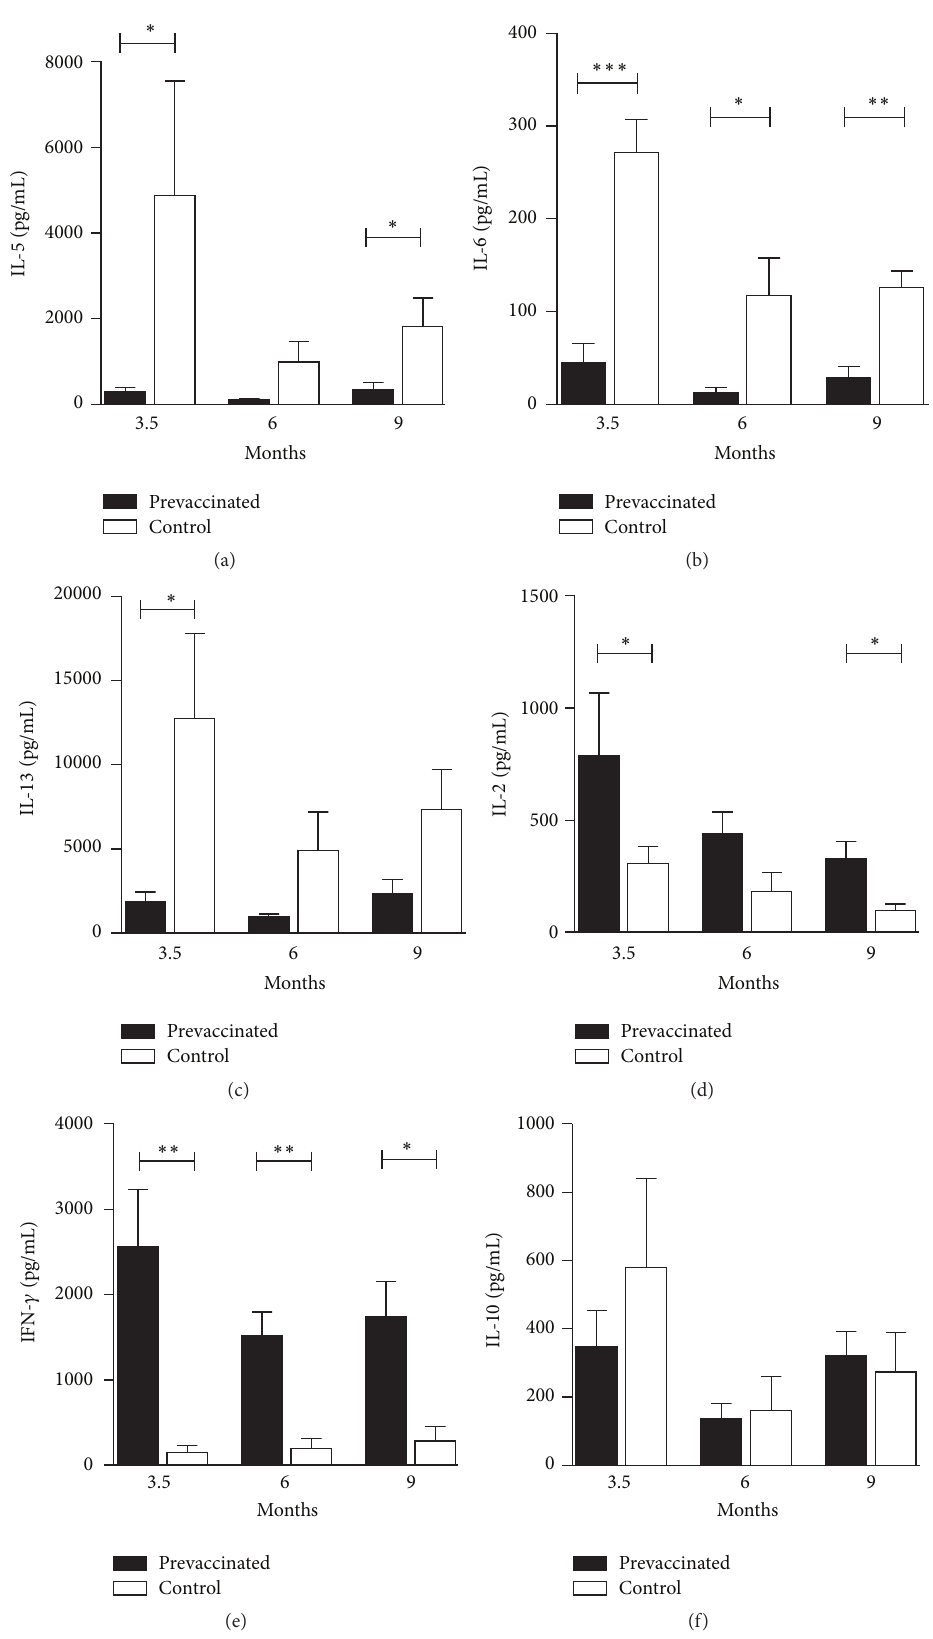
Figure 2: Levels of IL-5 (a), IL-6 (b), IL-13 (c), IL-2 (d), IFN- 𝛾 (e), and IL-10 (f) were determined in culture supernatants after in vitro restimulation of splenocytes with rPhl p 5. Data are displayed as means ± SEM ( 𝑛 = 5 ). ∗ 𝑝 < 0.05 ; ∗∗ 𝑝 < 0.01 ; ∗∗∗ 𝑝 < 0.001